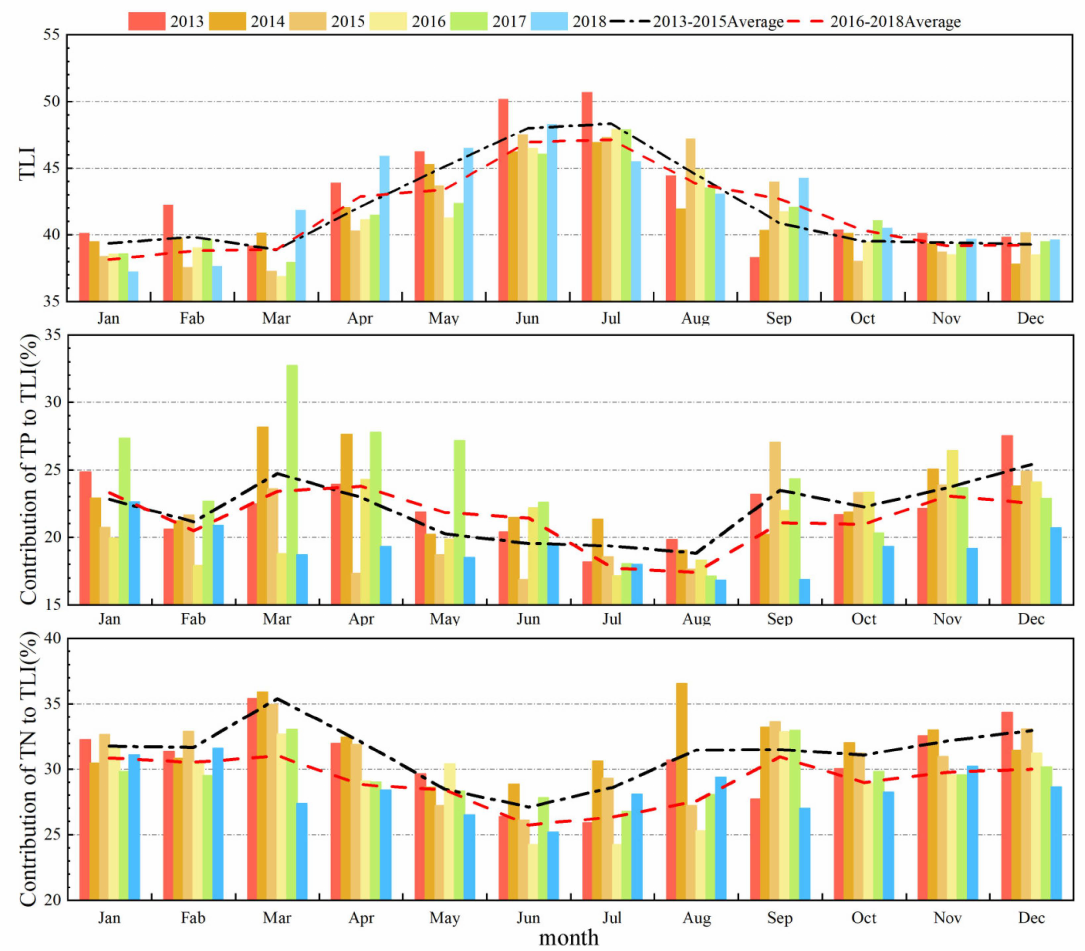
Figure 4. Monthly-scale TLI values ( top ) and monthly-scale contribution rates of TN ( center ) and TP ( bottom ) to